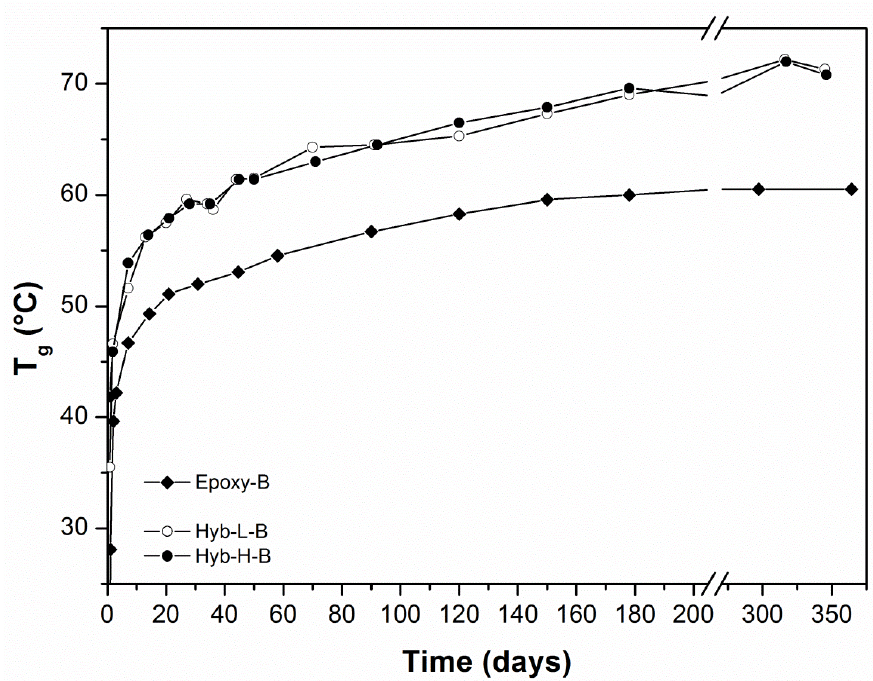
Figure 7. Temporal evolution of T g as a function of DES content for epoxy systems cured with PACM hardener.